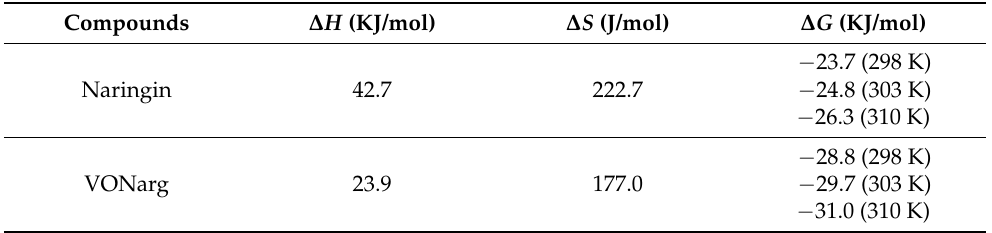
Table 6. Thermodynamic parameters for the systems naringin-BSA and VONarg-BSA. Compounds ∆ H (KJ/mol) ∆ S